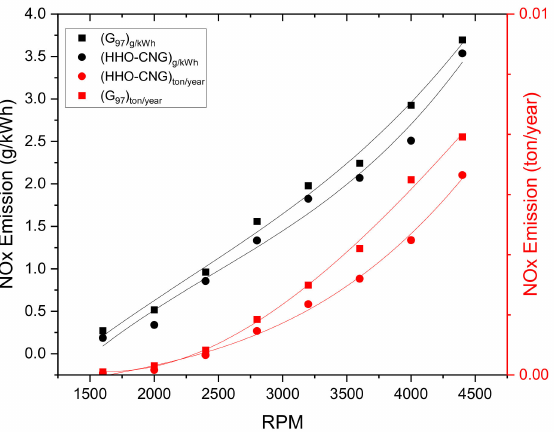
Figure 10. NOx emission variation with respect to engine speed in terms of parts per million and